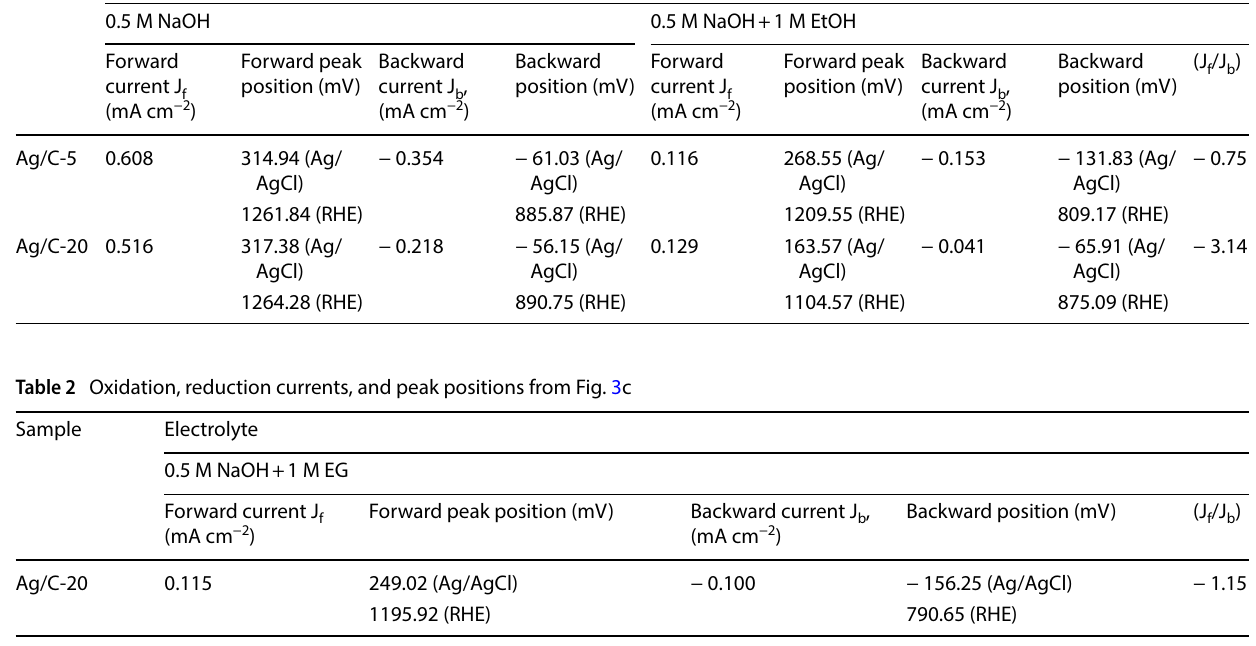
Table 1 Oxidation, reduction currents, and peak positions from Fig. 3a, b Sample Electrolyte